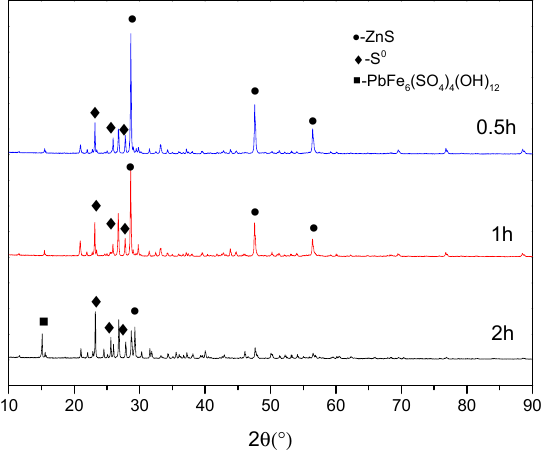
Figure 12. XRD patterns of leach residues with different leaching times.